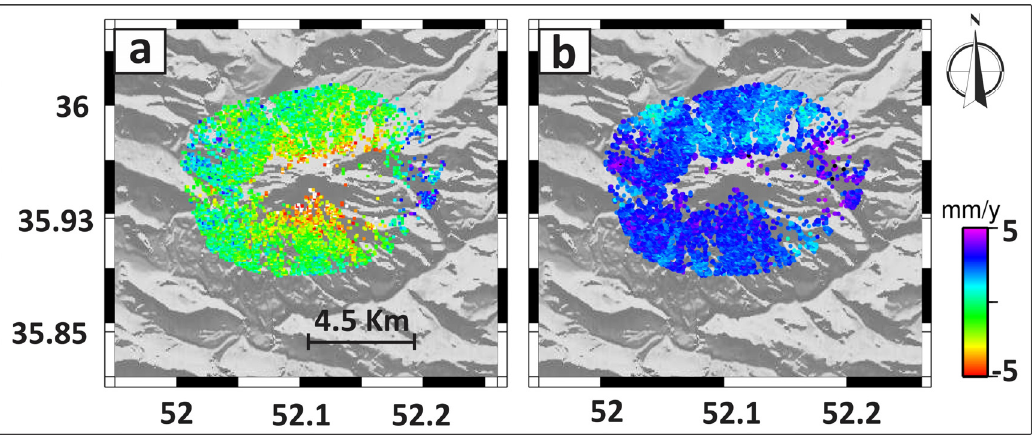
Figure 10. Decomposition of LOS displacement to vertical and horizontal components. ( a ) East-west motion; negative values correspond to motion toward the west and positive values towards the east. ( b ) Vertical motion; positive values correspond to